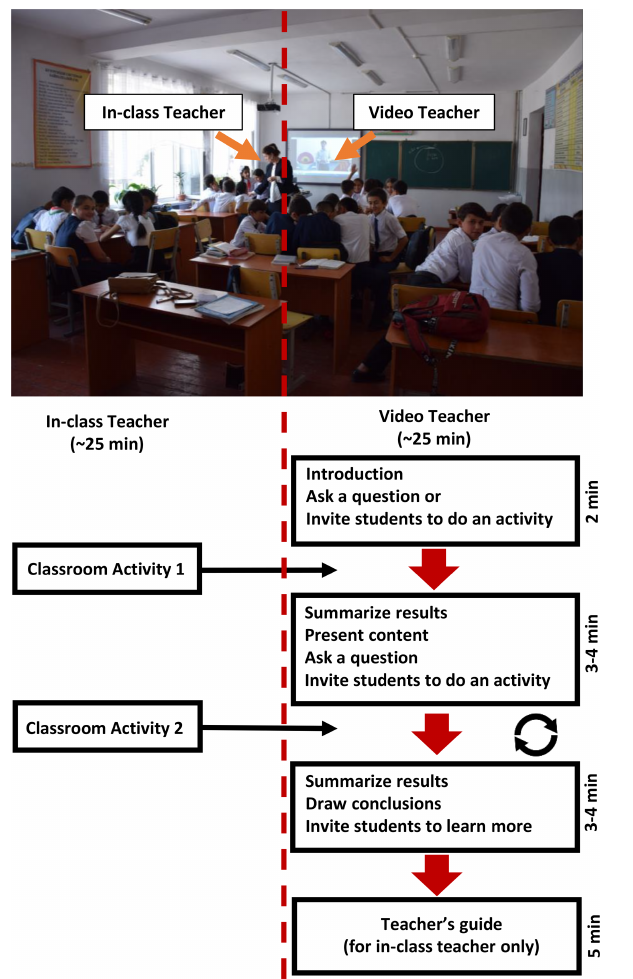
Figure 2. Paired teaching pedagogy. The circular arrows demon- strate the passing of teaching between the in-class and video teach-